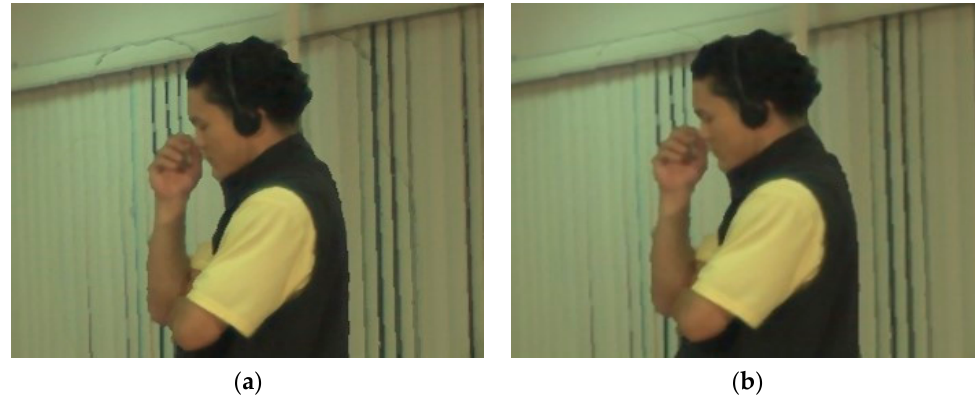
Figure 11. Example of brightness adjustment. ( a ) Nonadjusted and ( b ) adjusted.